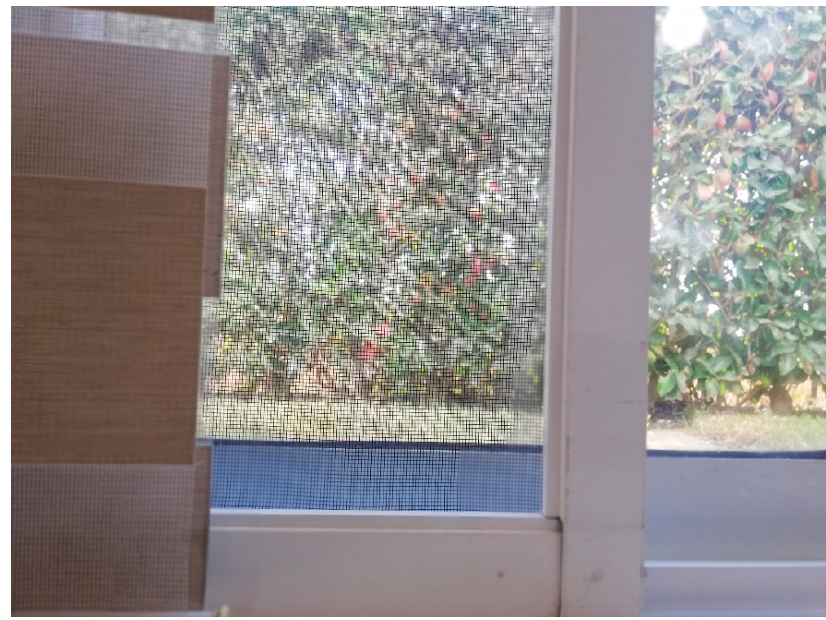
Figure 24. Different Materials tested in scenario 3.